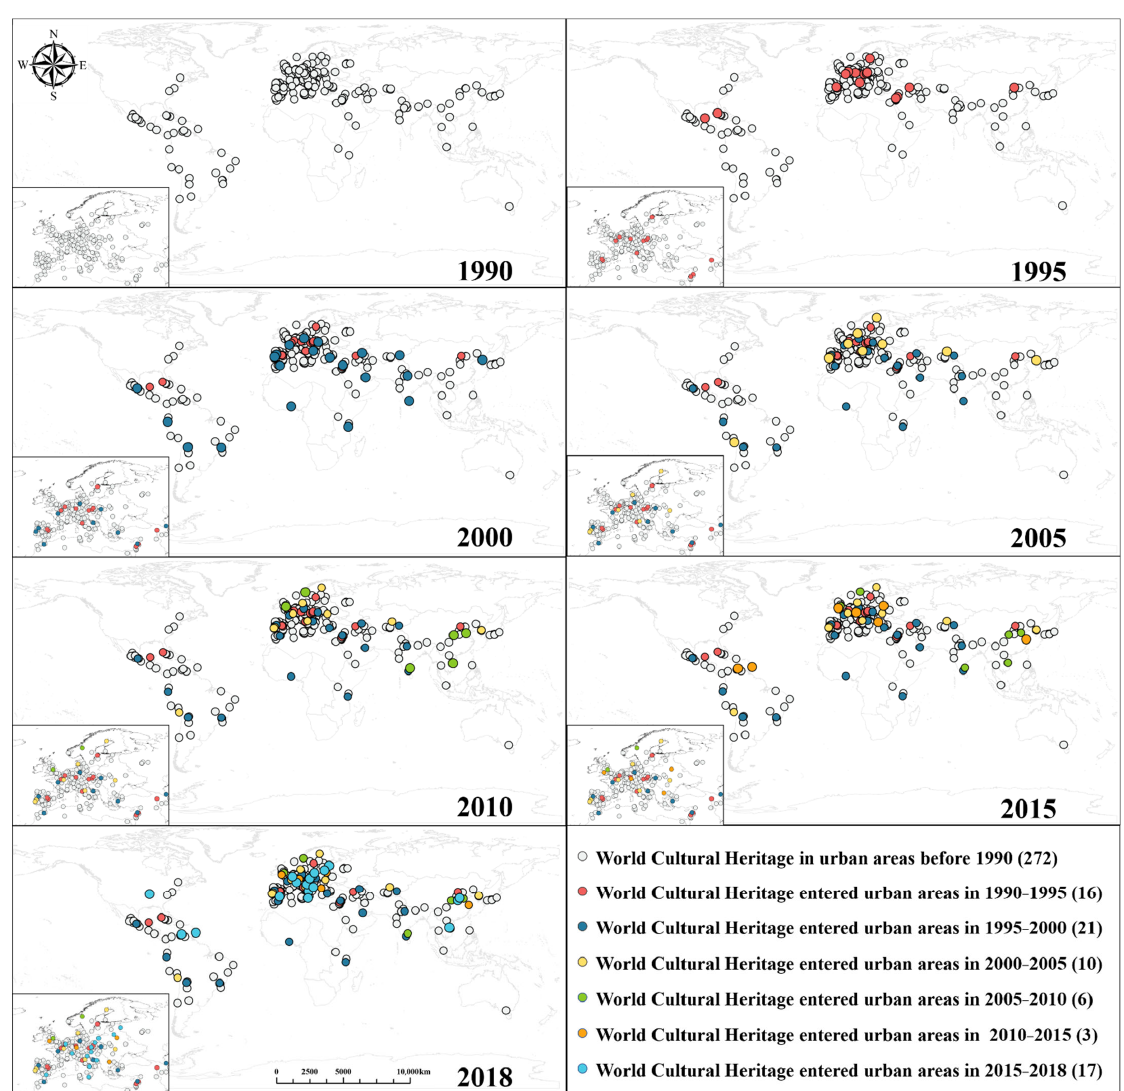
Figure 9. The evolution of the spatial relationship between world cultural heritage sites and neigh- bouring towns from 1990 to 2018. A count of world cultural heritage sites that have been incorporated into neighbour ‐ ing towns since 1990 (Figure 10) shows that the number of these sites has been increasing, and this increase can be divided into three phases according to the rate of increase. Of the